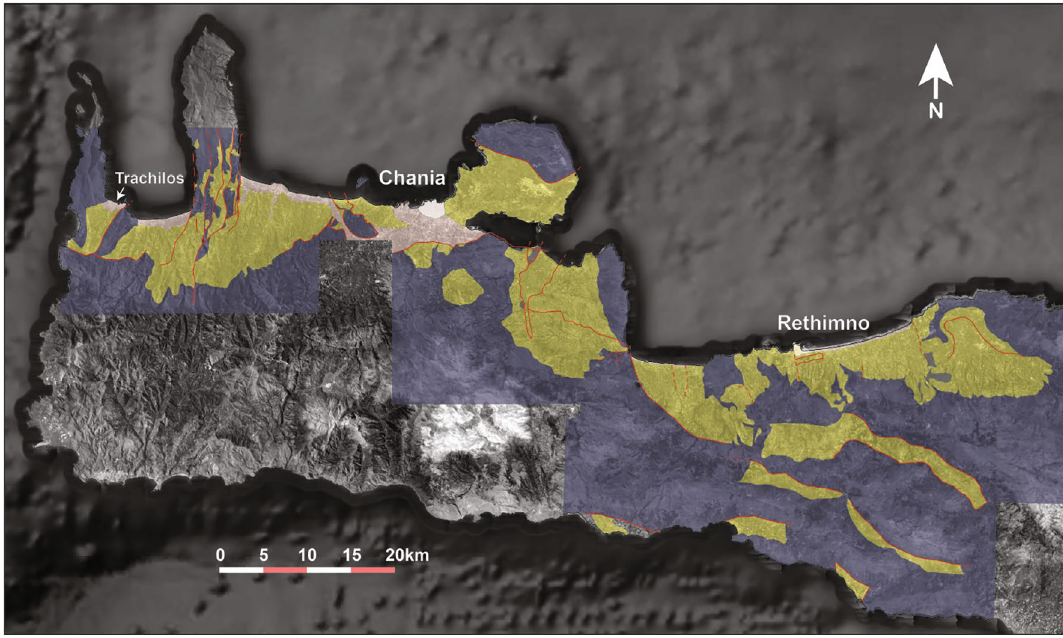
Figure 1. Google Earth satellite image of western Crete (imagery date 9–1-2018) with the distribution of Upper Cenozoic sediments after Freudenthal 5 and Meulenkamp 10 . Legend: undifferentiated basement (grey); Neogene (yellow); Quaternary (rose); not mapped (no color). Location of the Trachilos site is shown by